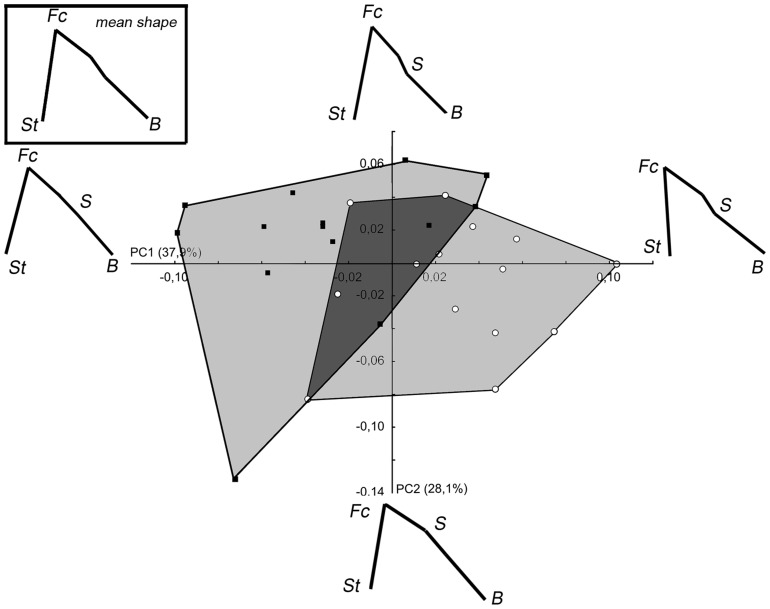
PCA_Gor: Set 1 (facial block orientation) in Gorilla.Convex hulls gather specimens from each sex. For legend see figure 4.